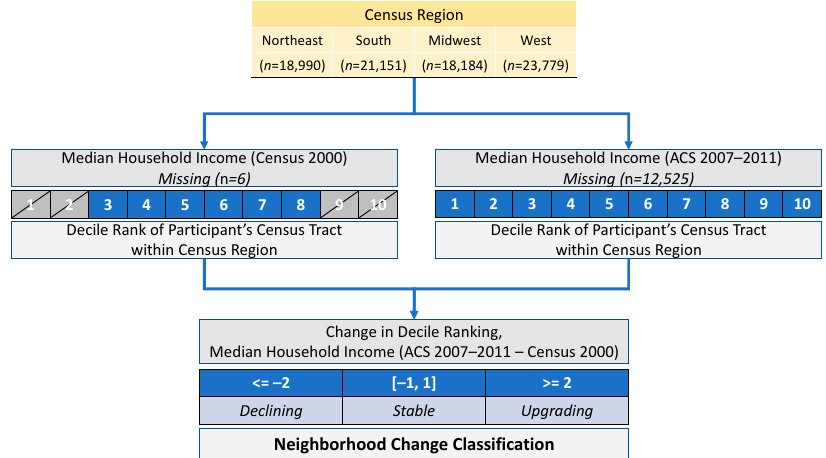
Figure 2. Diagram of neighborhood change variable derivation.